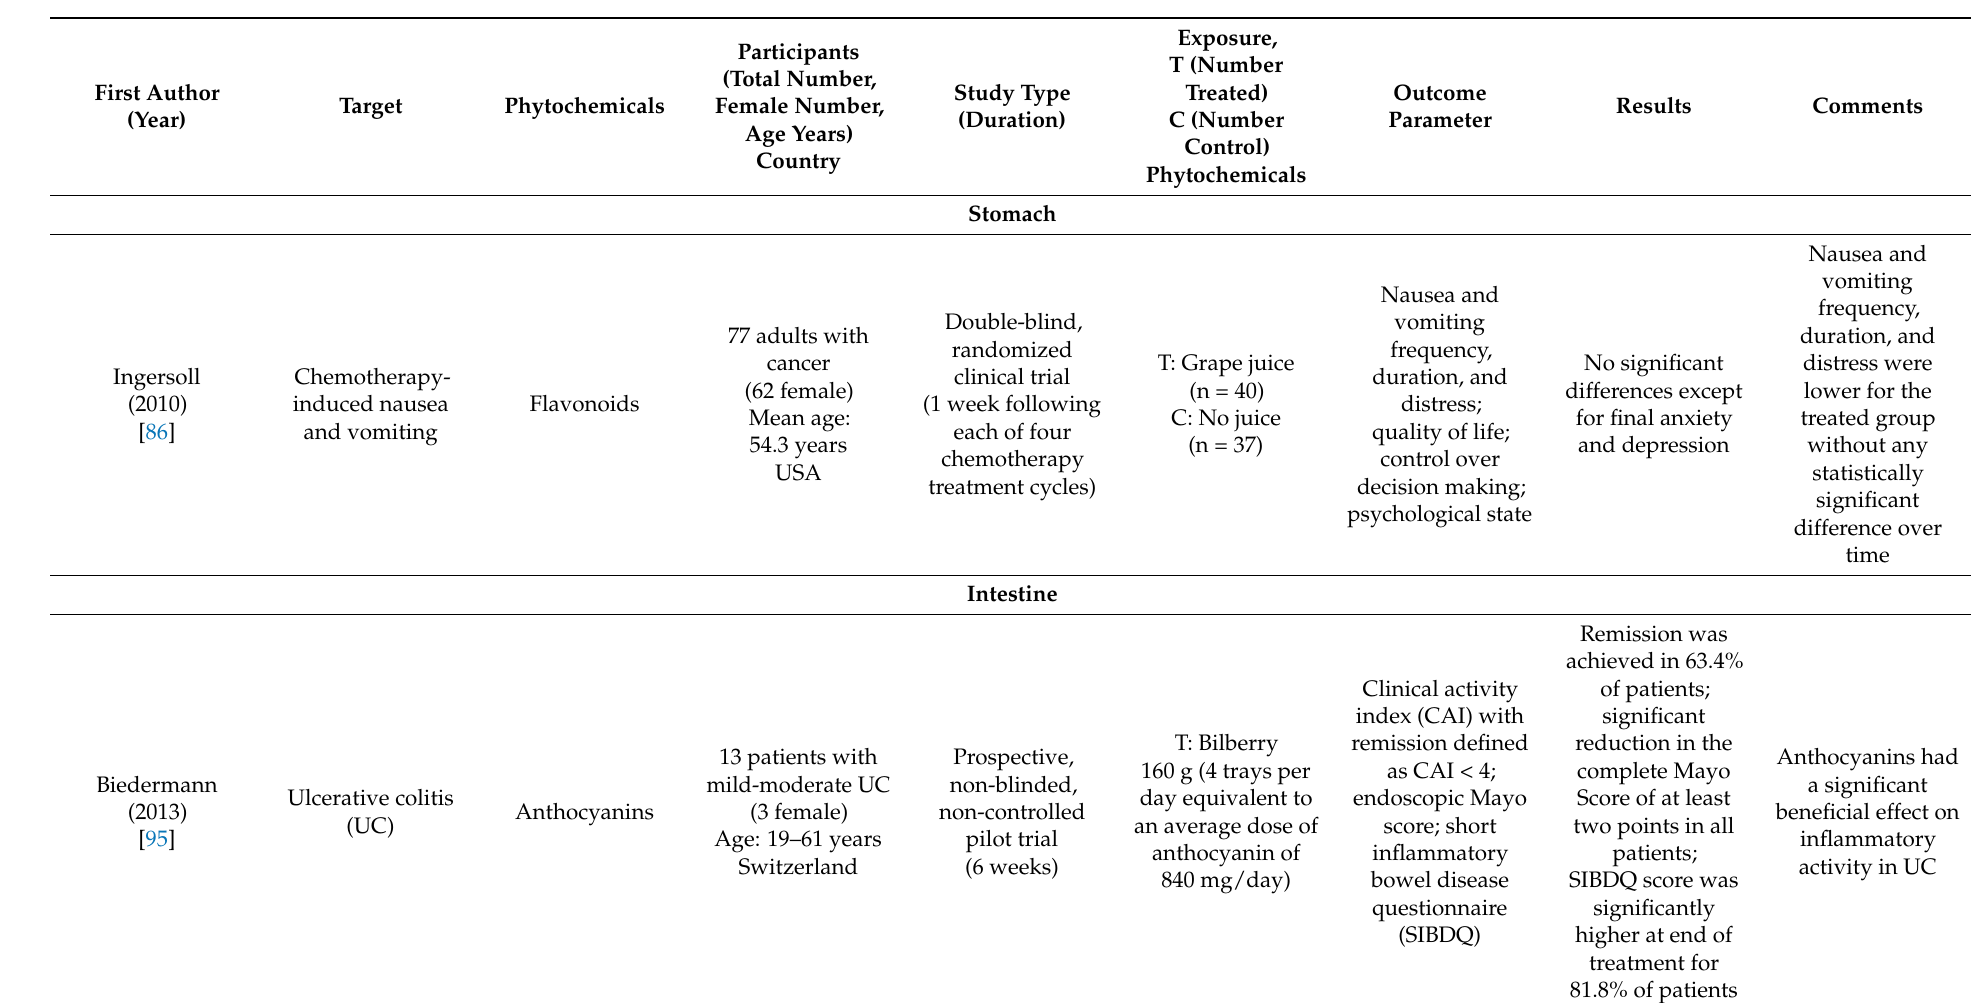
Table 5. Summary of selected studies regarding the therapeutic area of digestive